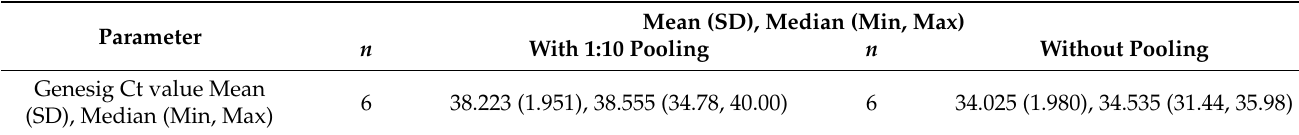
SD = standard deviation. Min = minimum. Max = maximum. n = number. Ct = cycle threshold. TMA = transcription-mediated amplification.